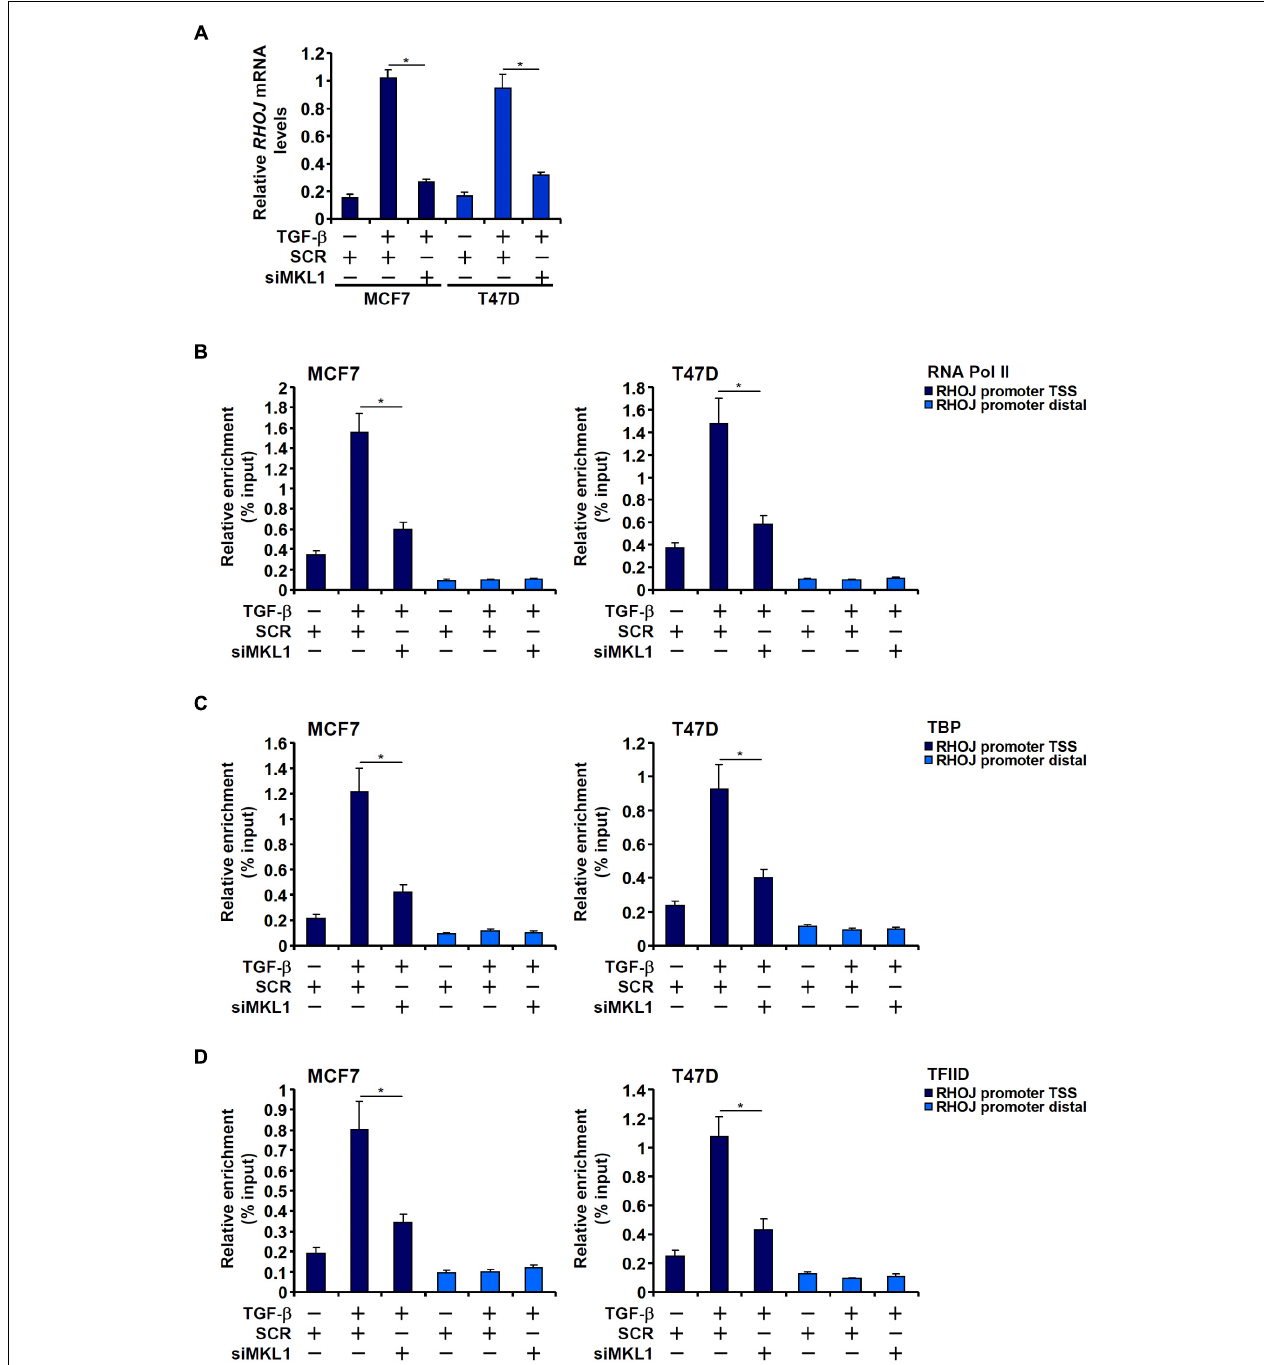
FIGURE 1 | MKL1 deficiency impedes the assembly of the preinitiation complex. (A–D) MCF7 (left panel) and T47D (right panel) cells were transfected with indicated siRNAs followed by treatment with TGF- β for 48 h. RHOJ expression was examined by qPCR (A) . ChIP assays were performed with anti-RNA polymerase II (B) , anti-TBP (C) , and anti-TFIID (D) . All experiments were performed in triplicate wells and repeated three times, and one representative experiment is shown. Data represent mean ± SD. * p < 0.05, two-tailed t -test. MKL1 depletion attenuated RHOJ expression and dampened the recruitment of RNA polymerase II, TBP, and TFIID to the RHOJ